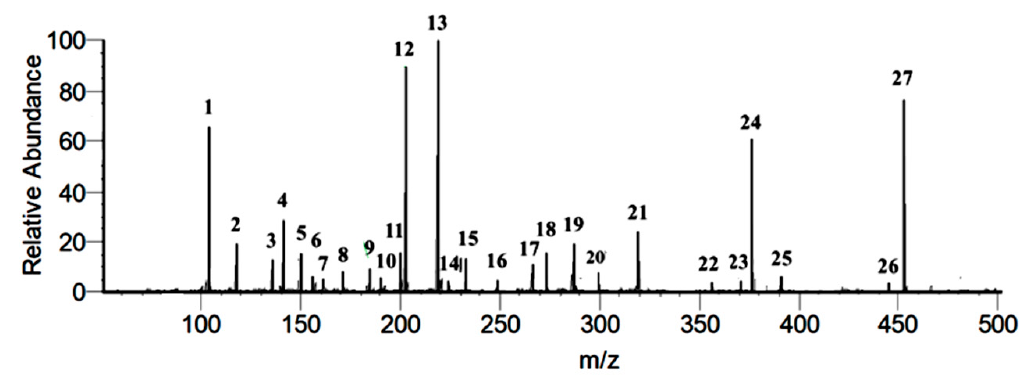
Figure 1. PSI-MS parent ion peak of the identified compounds of DIBEt.